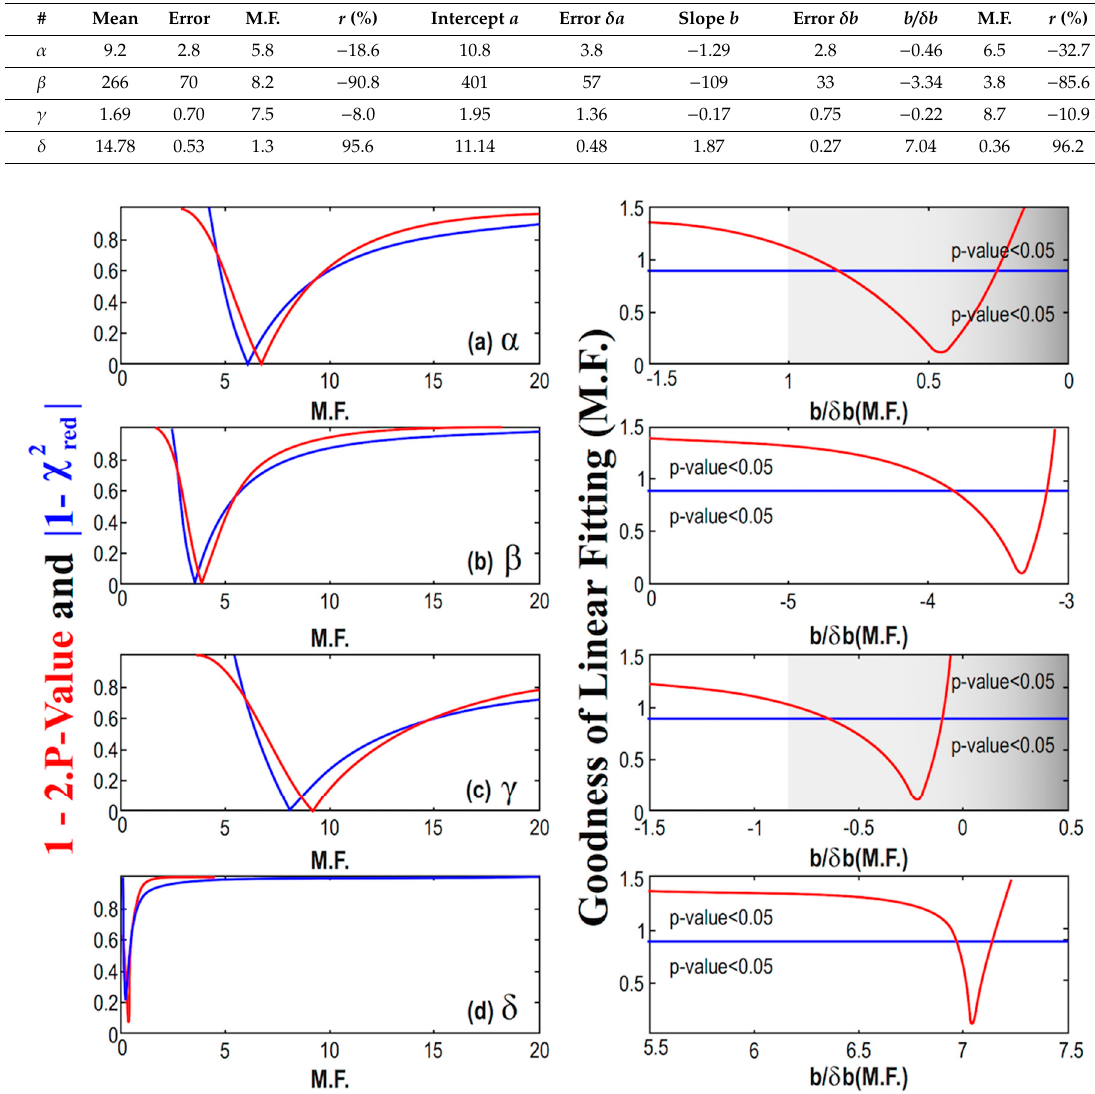
Table 5. Statistical Analysis of Model Parameters vs. M